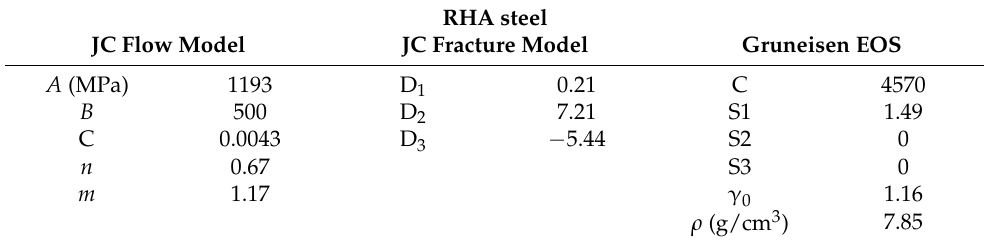
Table 2. Modelling parameters the RHA steel, [21,33].